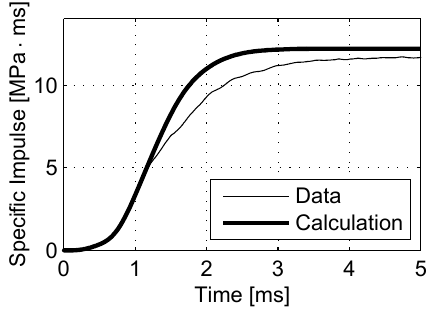
Fig. 13. Example of calculated versus recorded